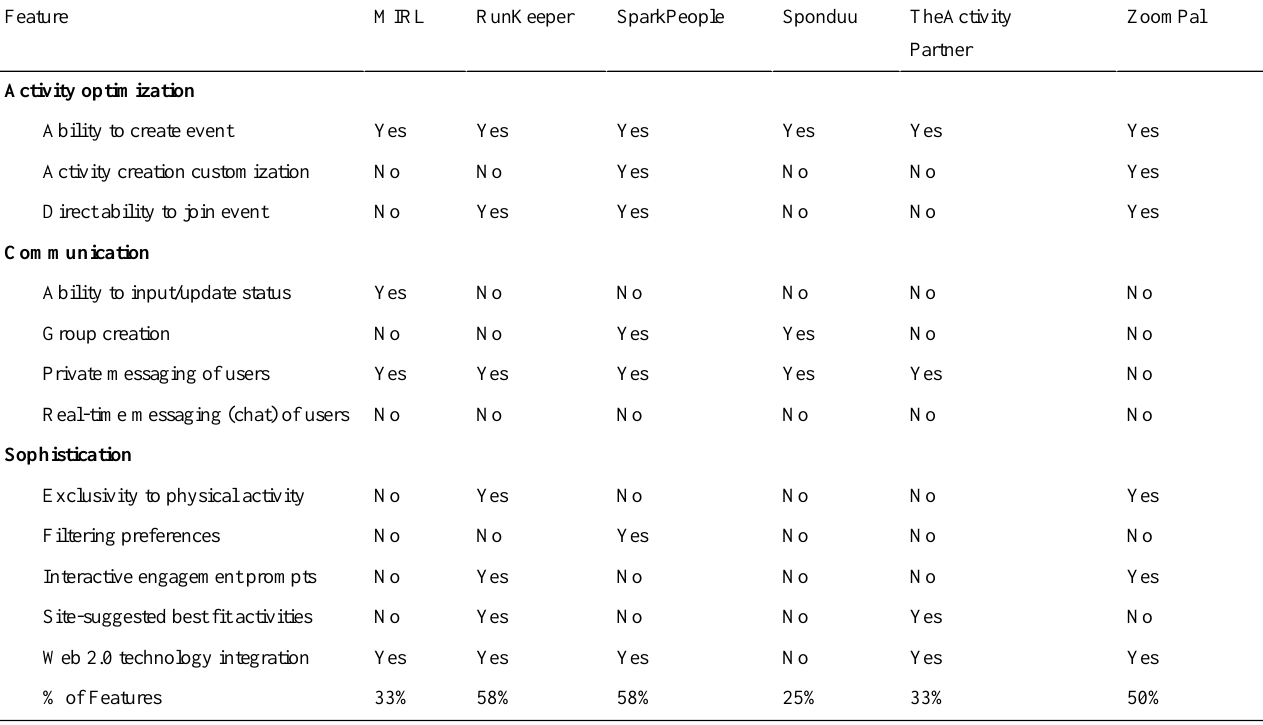
Table 5. Features of online social networks that connect users to physical activity partners